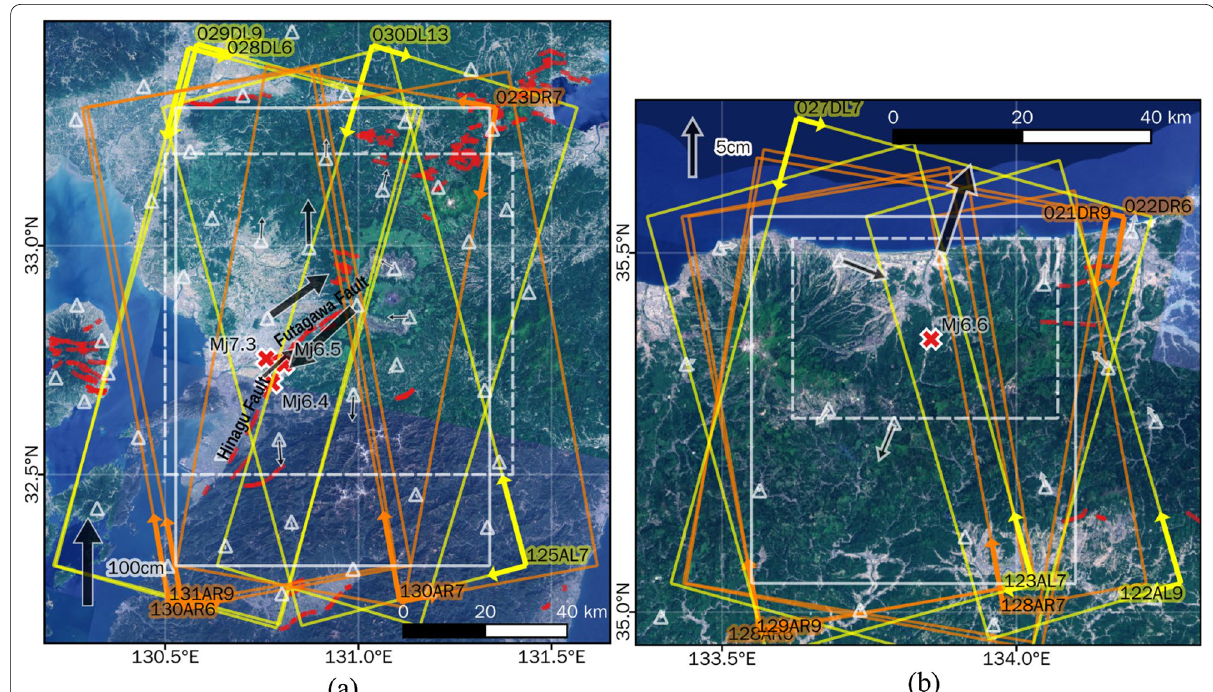
Fig. 2 Optical images of the areas of interest in a Kumamoto and b Tottori. The orange and yellow rectangles denote footprints of the right- and left-looking SAR data, respectively. Note that the footprints do not correspond to the full observation area of the original dataset because the processed data were clipped to fit the target area. The solid and dashed white rectangles denote the enlarged areas shown in the following figures (except Fig. 6) and the excluded deformation area used for the reference, respectively. The white triangles and accompanying black arrows denote GNSS CORS and their horizontal coseismic displacement. The red crosses and lines denote the epicenter of the earthquakes and known active faults, respectively (Nakata and Imaizumi